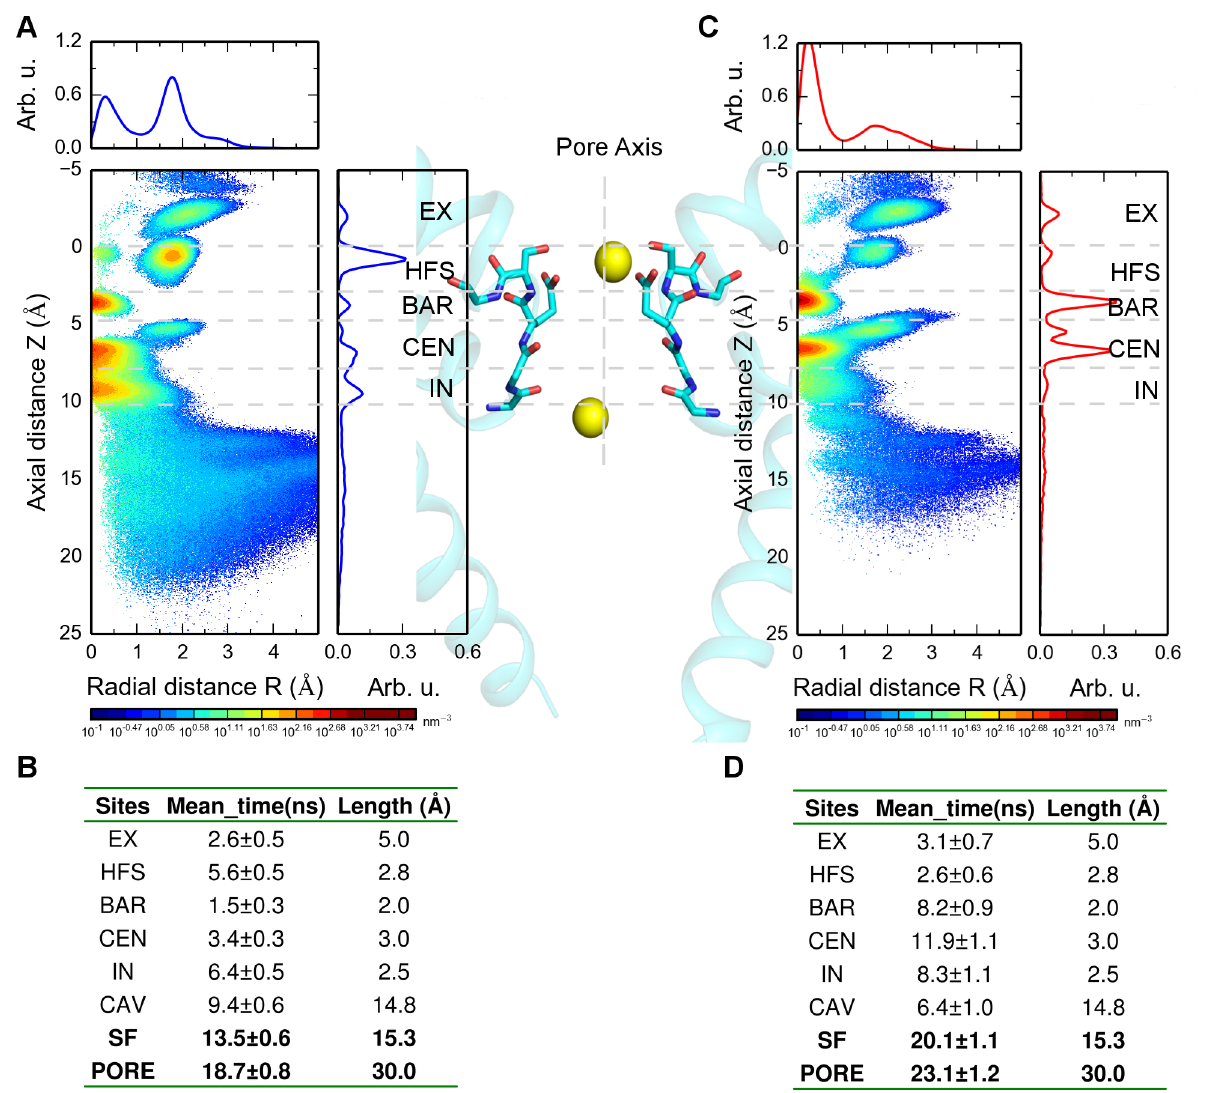
Figure 4. Ion distribution probability density map. A) Ion distribution of inward simulations labeled with respective interacting sites [4], lower left: 2-D (axial and radial distribution) density; lower right: 1-D axial distribution along the pore axis; upper left: 1-D radial distribution from the center of the pore axis. B) Inward dwell time in respective interacting sites (158 ion conduction events from four simulations were taken for analysis). C) Ion distribution of outward simulations labeled with respective interacting sites [4], lower left: 2-D (axial and radial distribution) density; lower right: 1-D axial distribution along the pore axis; upper left: 1-D radial distribution from the center of pore axis. D) Outward dwell time in respective interacting sites (79 ion conduction events from four simulations were taken for